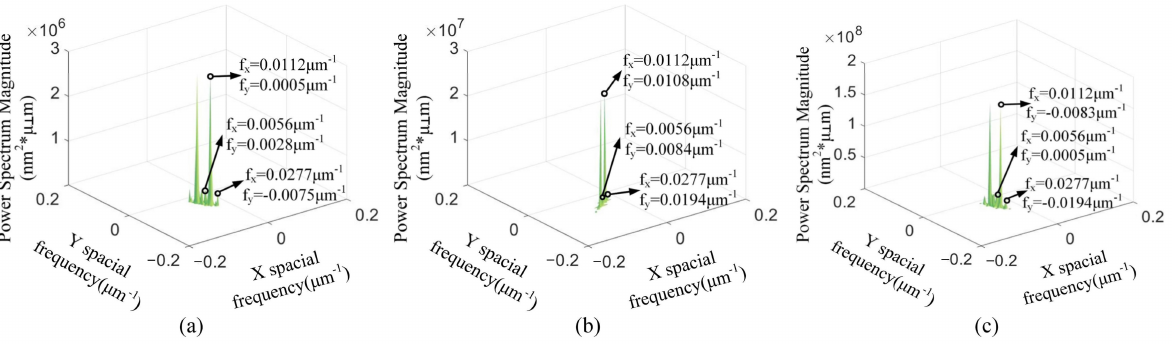
Figure 4. The 2D PSD results with different cutting depths: ( a ) a p = 3 µ m, ( b ) a p = 6 µ m, ( c ) a p = 9 µ m.